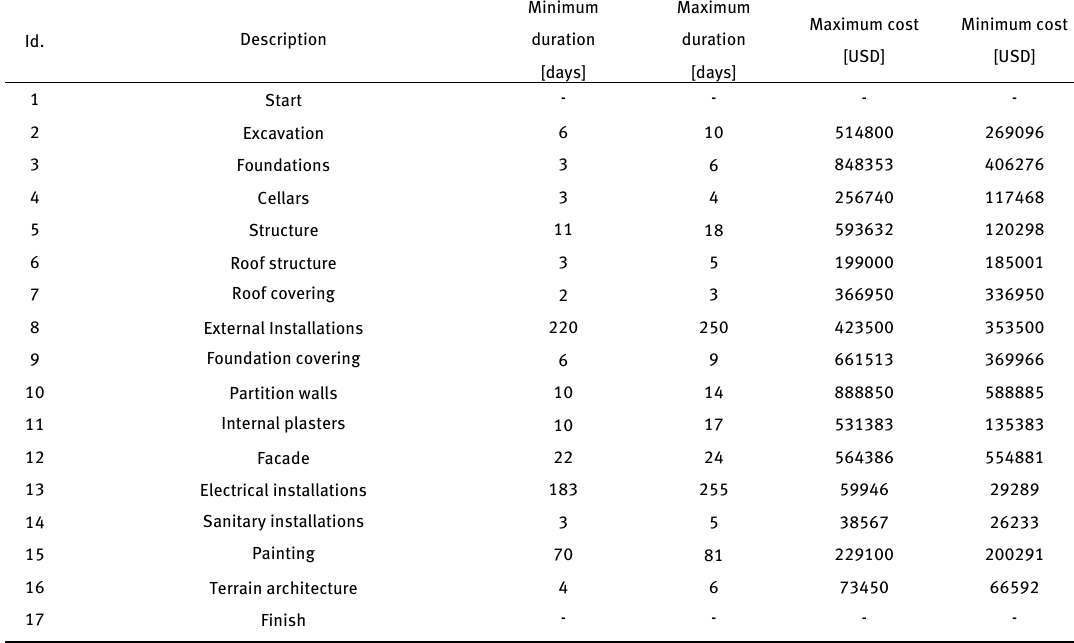
Table 1: The example project schedule - initial data